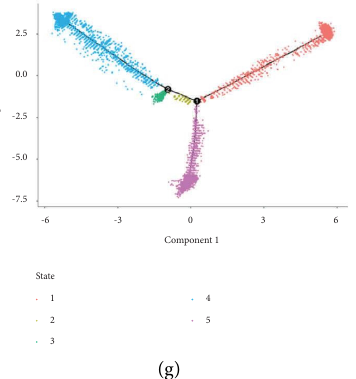
Figure 2: Cell clustering and trajectory analysis based on the scRNA-seq data: (a) scatter plot of 23 clusters processed by the UMAP algorithm, (b) scatter plot of 10 cell types obtained through annotation, (c–d) dot plot of the expression of major marker genes in diferent clusters and cell types, and (e–g) diferentiation trajectory of 3 branches with diverse pseudotime, cell types, and